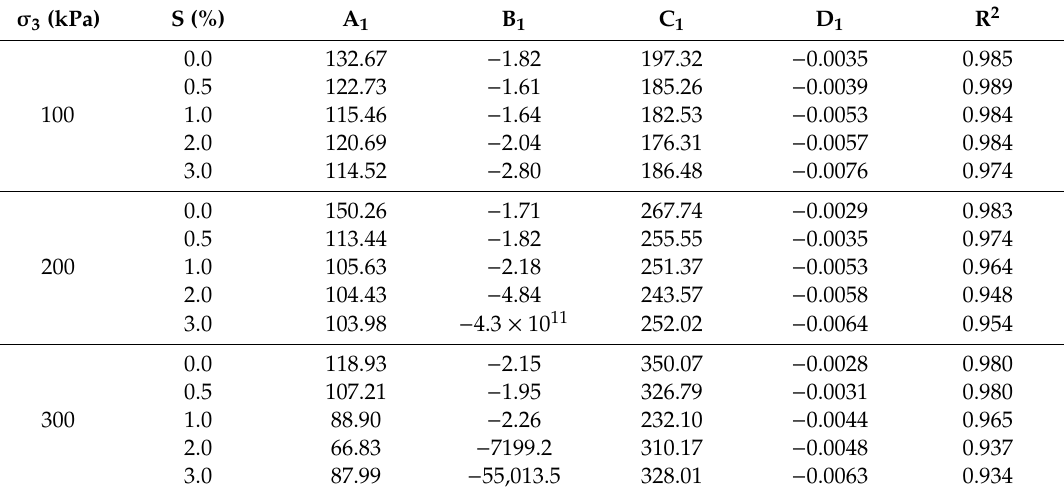
Table 3. Parameters of exponential function that can reflect the relation between ( σ 1 − σ 3 ) f and freeze-thaw cycle